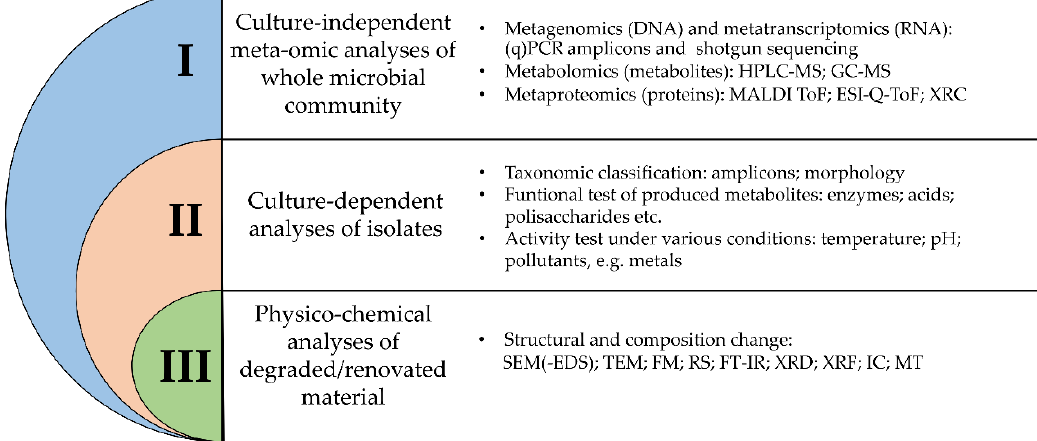
Figure 1. Overview of different methodologies for the study of microbial communities in relation to their impact on organic and inorganic materials. (q)PCR—(quantitative) polymerase chain reaction; HPLC-MS—liquid chromatography-mass spectrometry; GC-MS—gas chromatography-mass spectrometry; MALDI ToF—matrix-assisted laser desorption/ionization time-of-flight; ESI-Q-ToF—electrospray-ionization quadrupole time-of-flight mass spectrometry; XRC—X-ray crystallography; SEM(-EDS)—scanning electron microscopy (coupled with energy-dispersive X-ray spectroscopy); TEM—transmission electron microscopy; FM –fluorescence microscopy; RS—Raman spectroscopy; FT-IR—Fourier transform coupled infrared spectroscopy; XRD—X-ray diffraction; XRF—X-ray fluorescence; IC—ion chromatography; MT—microtomography.